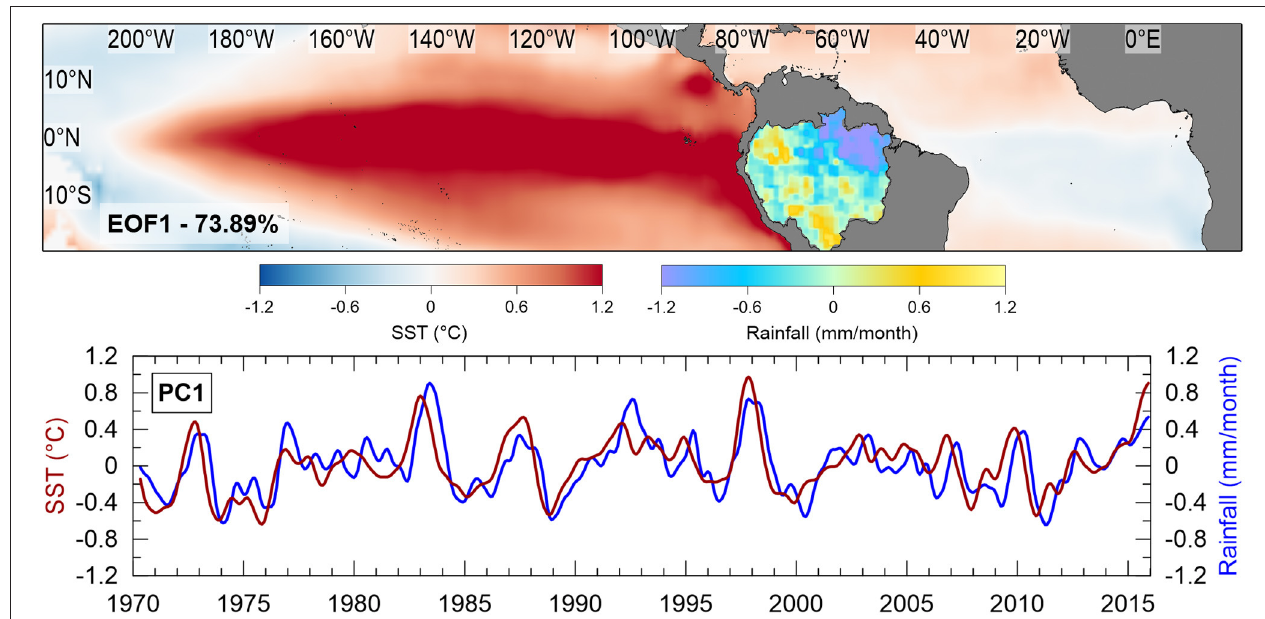
FIGURE 1 | First EOF mode of 4 month-lagged covariance matrix between SST and rainfall (normalized scale by 10 3 ), the Squared Covariance Fraction (SCF) in percentage, and the first Principal Component